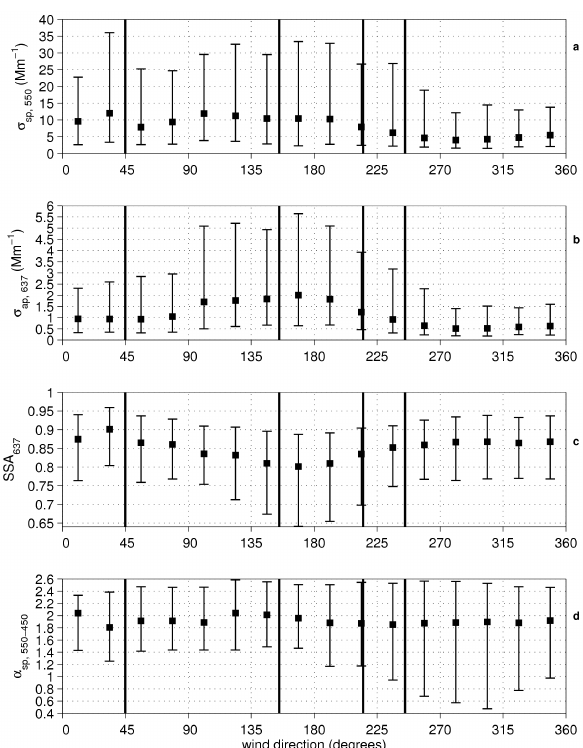
Fig. 6. 739 Fig. 6. The 10th percentile (lower error bar), median (square), and 90th percentile of (a) total scattering coefficient at 550nm, (b) absorption coefficient at 637nm, (c) single scattering albedo at 637nm, and (d) scattering ˚Angstr¨om exponent between 450 and 550nm as a function of wind direction at Puijo in Sep 2006–Sep 2010. The vertical lines are the limits for the geographical sectors for local source